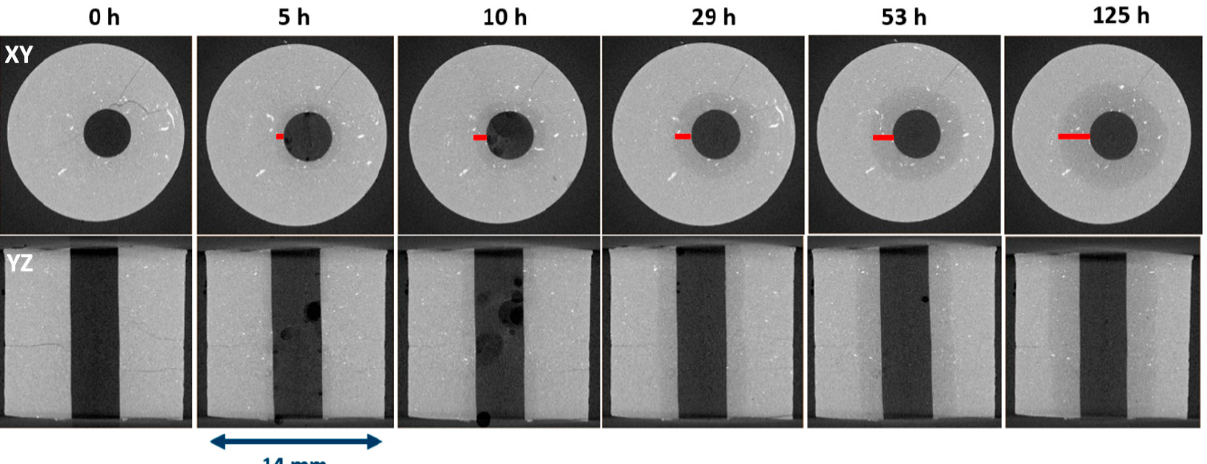
Figure 8. X-ray tomography XY ( top ) and YZ ( bottom ) cross-sections through the cylindrical shale sample B (in a configuration where the surface exposed to acid was perpendicular to the bedding plane) after different exposure times (0, 5, 10, 29, 53 and 125 h). The red stripe indicates the extent of the etched volume. The channel diameter is ~4 mm.